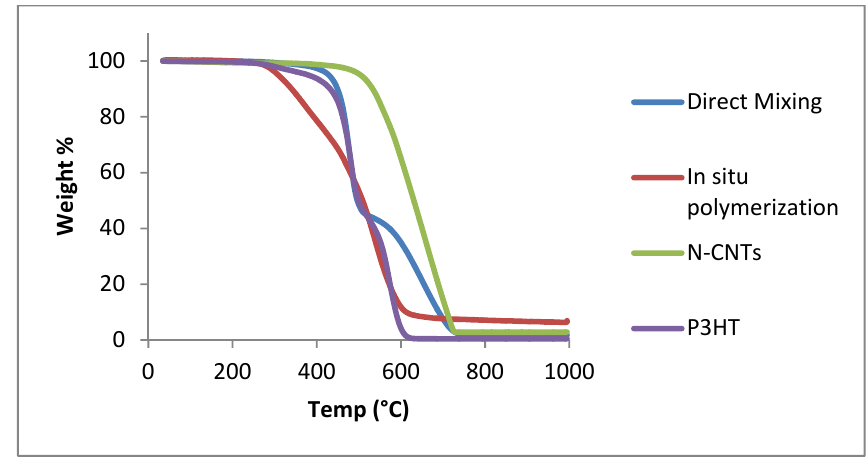
Figure 7. Thermogravimetric analysis of N-CNTs, P3HT and P3HT/N-CNTs